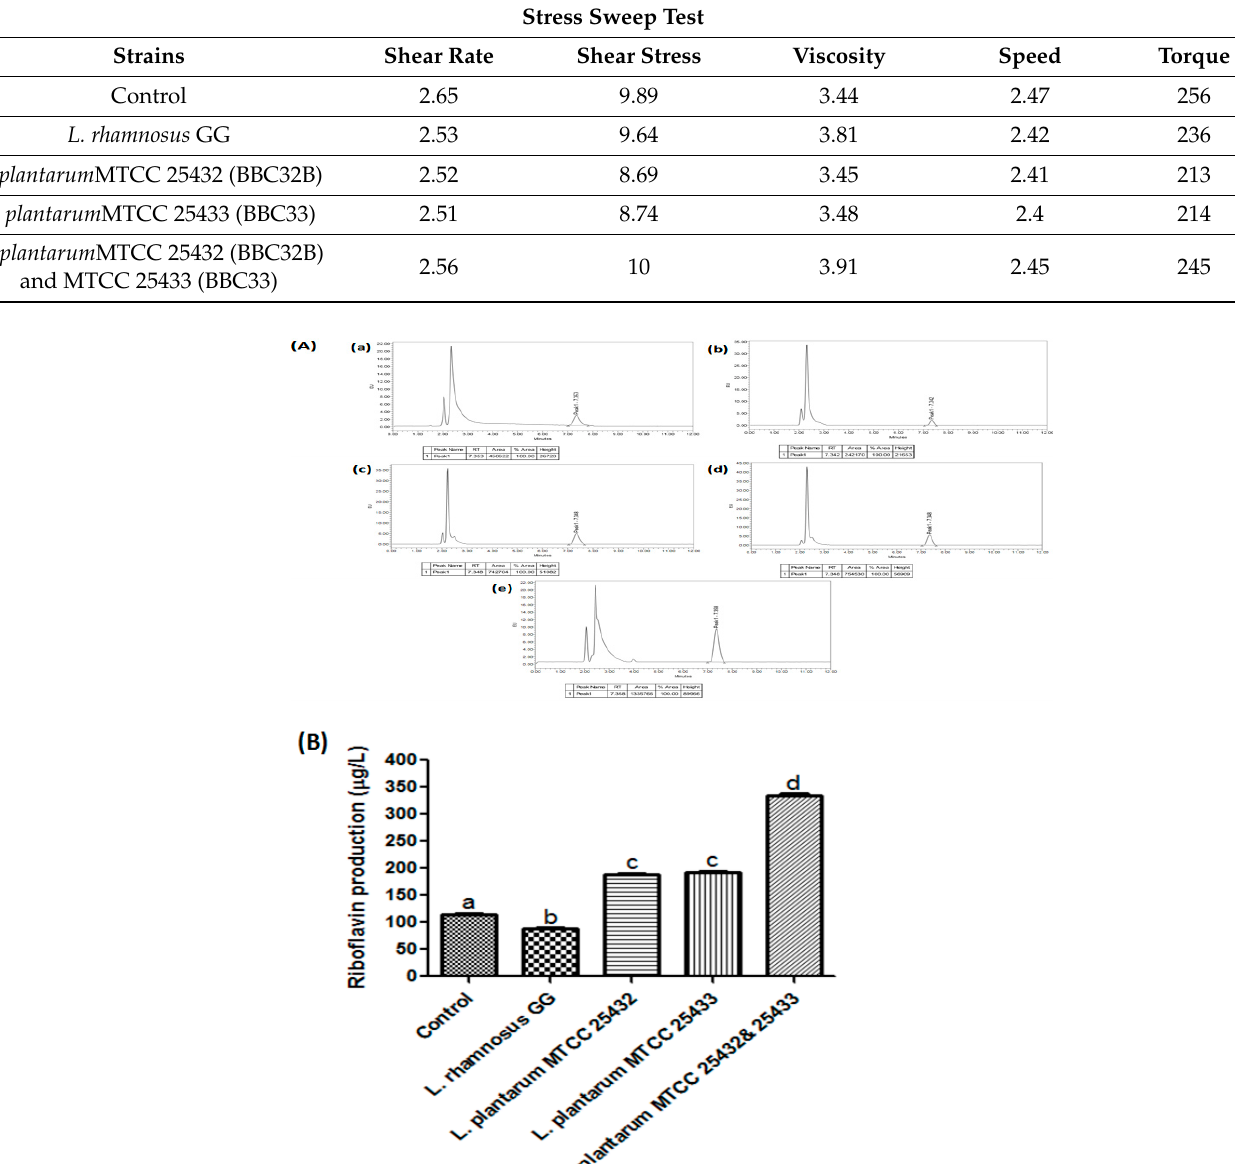
Table 2. Rheological properties; Stress sweep test indicated the torque values among the pure cultures of L. plantarum MTCC 25432 (BBC32B) and MTCC 25433 (BBC33) (245) combination followed by L. rhamnosus GG (236), L. plantarum MTCC 25433 (BBC33) (214) and L. plantarum MTCC 25432 (BBC32B) (213) which indicated the probiotic acceptability of the strains based on the rheology. The values are expressed as mean ± SEM of three independent experiments with significant difference ( p < 0.0001).